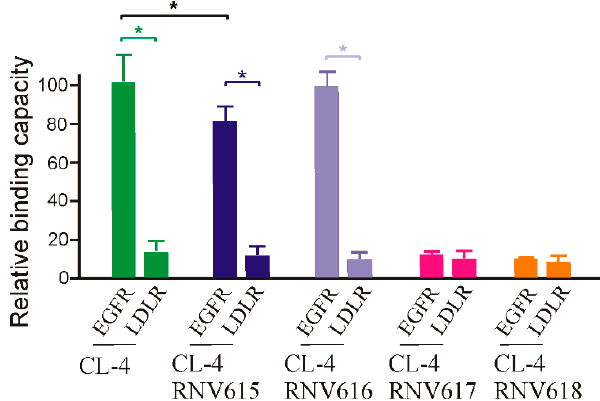
Figure 1. Relative binding capacity of different modified EGFR aptamer sequences and their specificity analysis using a negative target of the lipoprotein receptor protein (LDL-R) protein. EGFR protein was incubated with 100 nM of biotin labelled aptamers CL-4RNV615 to CL-4RNV618 for 1h, and the binding capacity was analysed by ELONA assay. * p < 0.05.